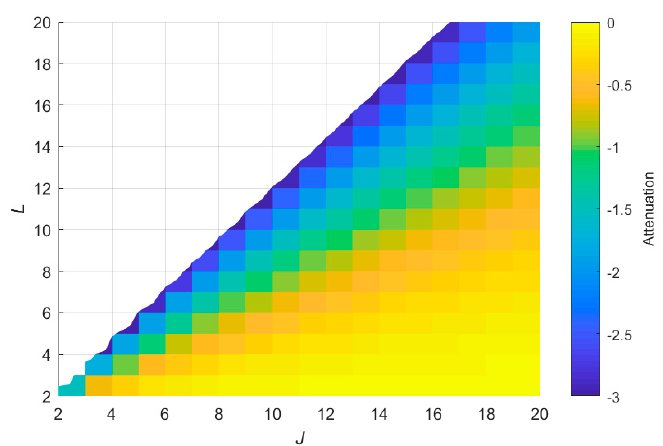
Figure 9. Relationship between max attenuation, the number of frequency compensation components J and block number L.